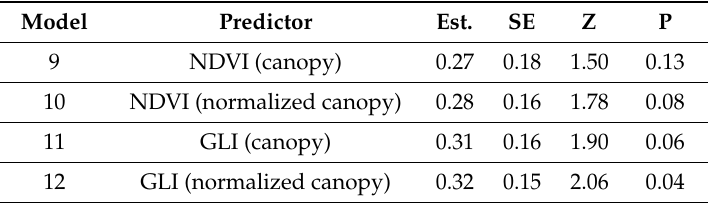
Table 3. Detecting leaf renewal in Moabi crowns at Lopé NP, Gabon using satellite data. Model estimates are derived from eight single variate generalized linear mixed models (binomial) for the probability of detecting leaf renewal from focal canopy time series (the mean value of all pixels within the canopy) and normalized canopy time series (the difference between the mean value of all pixels within the canopy and the mean value of all pixels in the surrounding forest buffer) of the normalized difference vegetation index (NDVI) and the green leaf index (GLI) derived from Sentinel-2 optical data. Mixed models included tree ID and year as random effects.